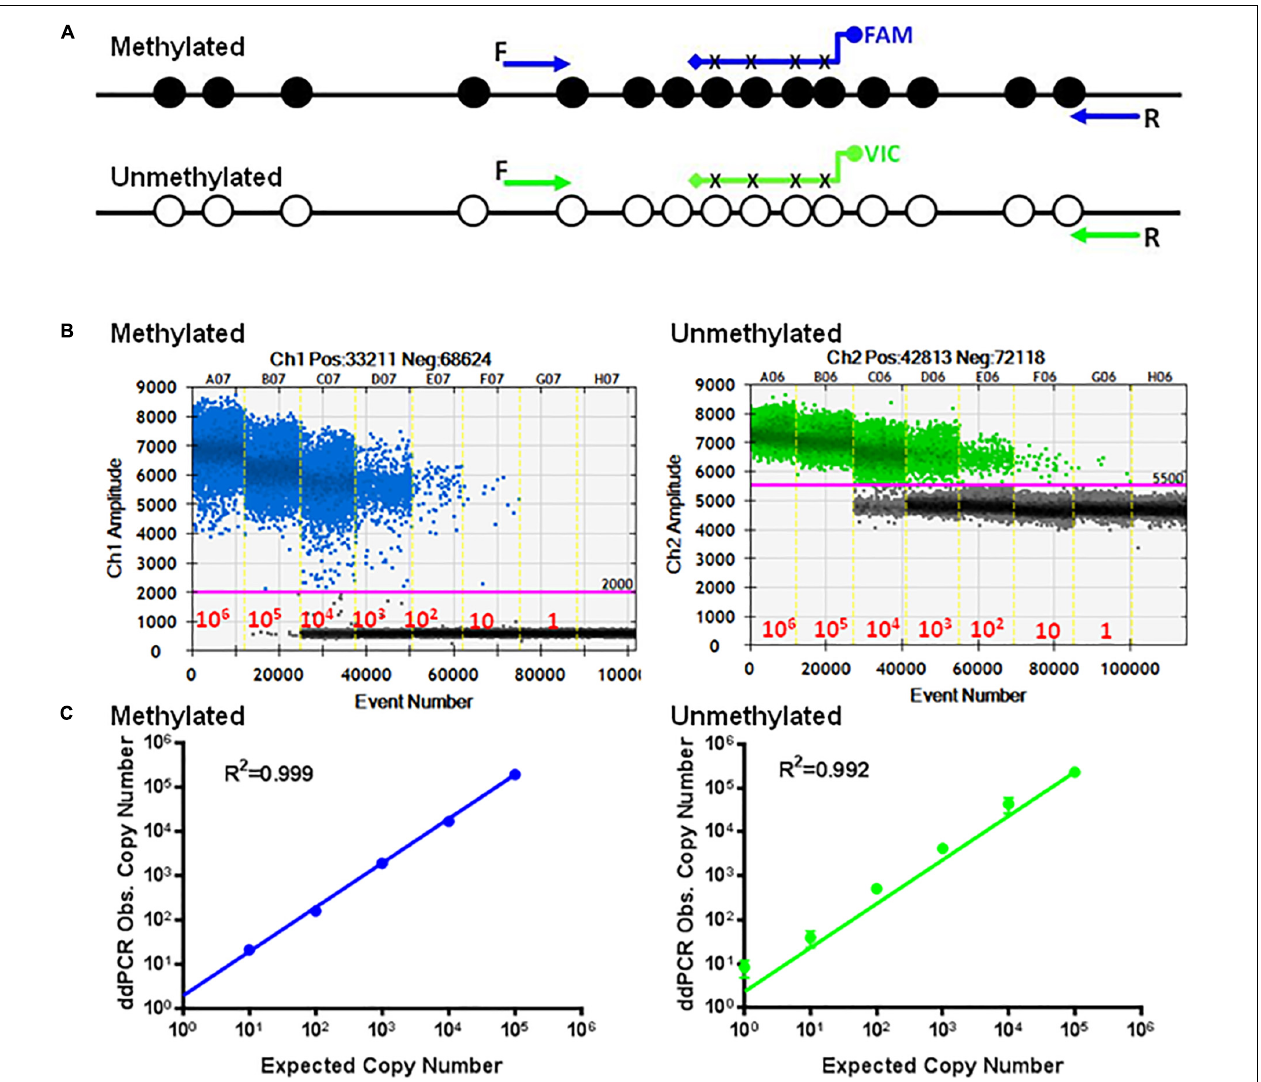
FIGURE 2 | Standard curves of methylated and unmethylated FOXP3 TSDR. (A) Schematic illustration of the TSDR of FOXP3 showing the specific primer set for methylated CpGs with specific probes conjugated with FAM and the specific primer set for unmethylated CpGs with specific probes conjugated with VIC that interrogate six CpGs of TSDR. (B) ddPCR using serially diluted plasmids (10 6 –1 copy/reaction). (C) Standard curves with linear regression analysis for methylated and unmethylated targets. The data shown are the average with standard deviation (SD) of three